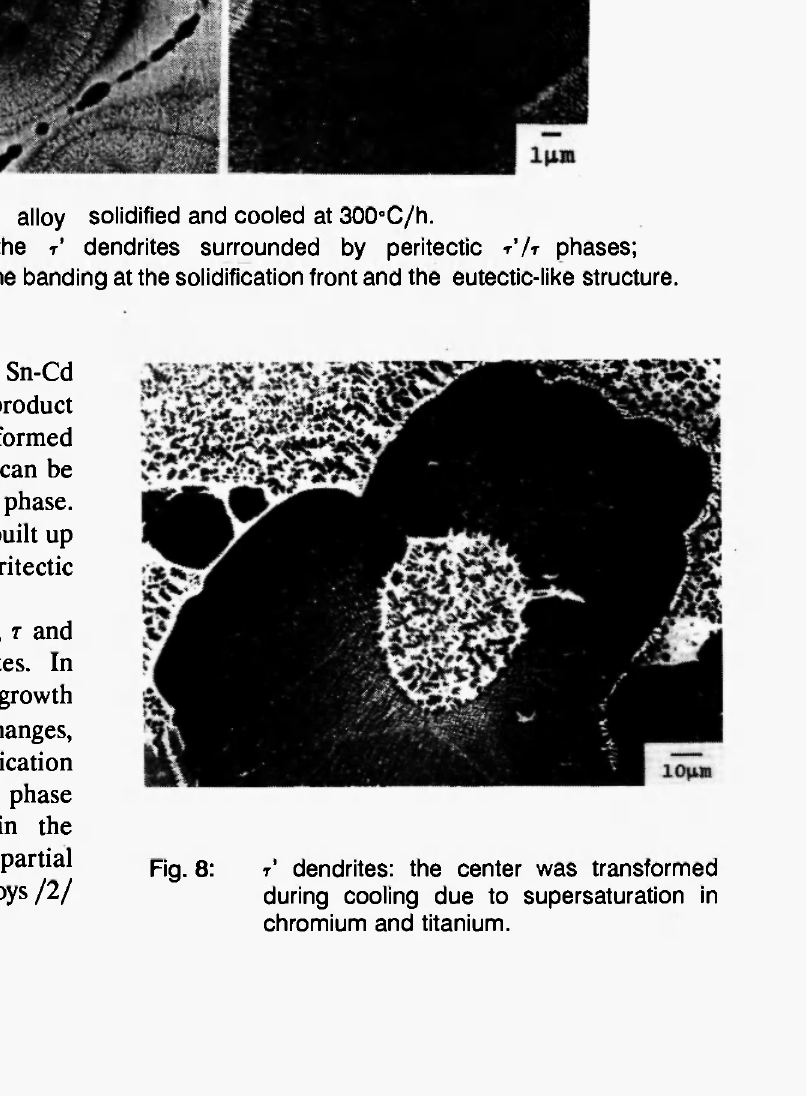
partial Fig. 8: τ' dendrites: the center was transformed during cooling due to supersaturation in chromium and